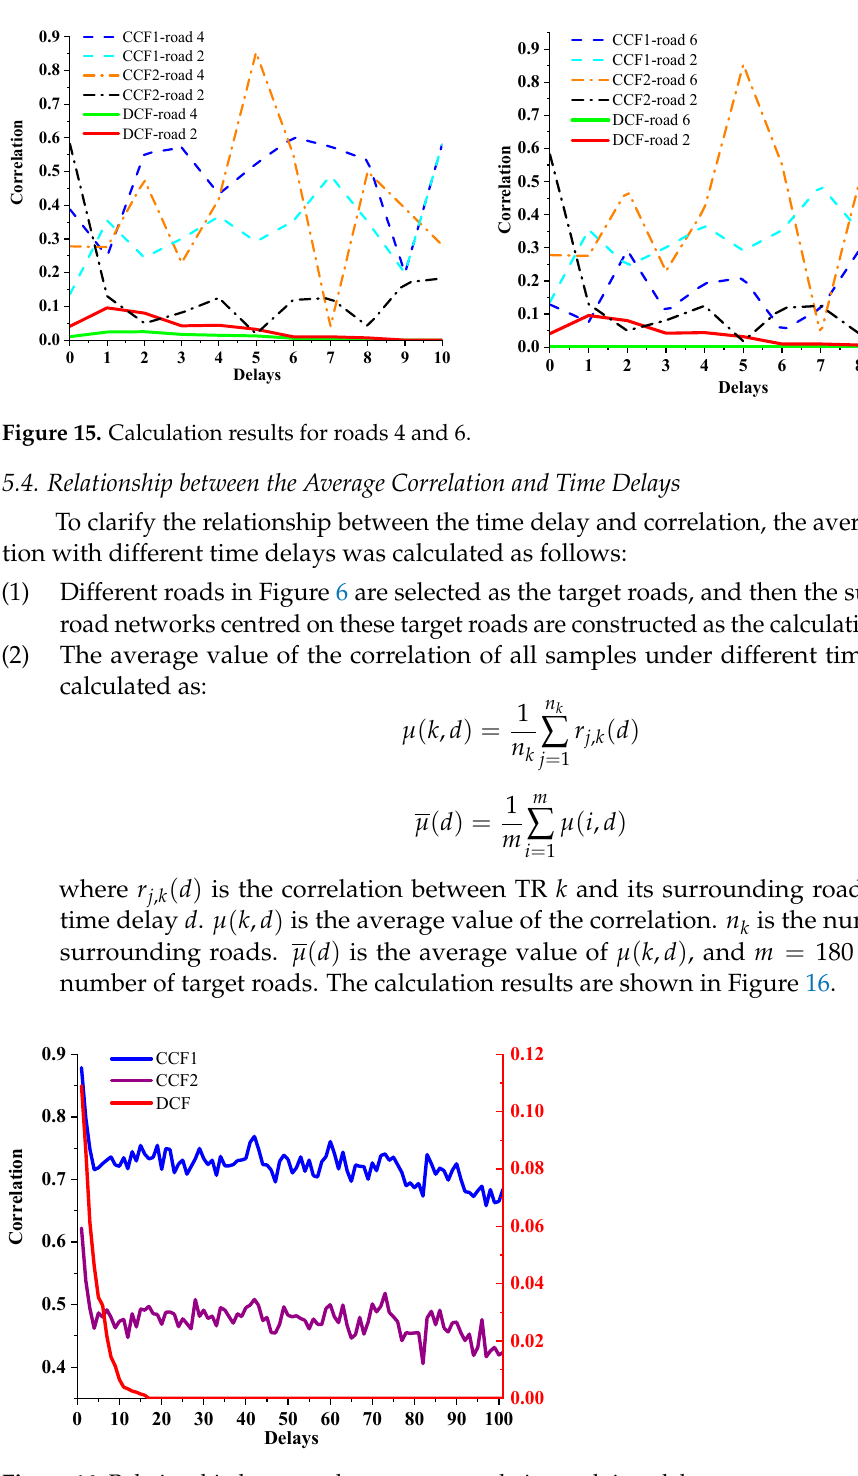
Figure 16. Relationship between the average correlation and time delays.